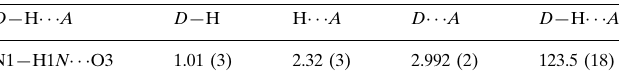
Hydrogen-bond geometry (A˚ , (cid:3)